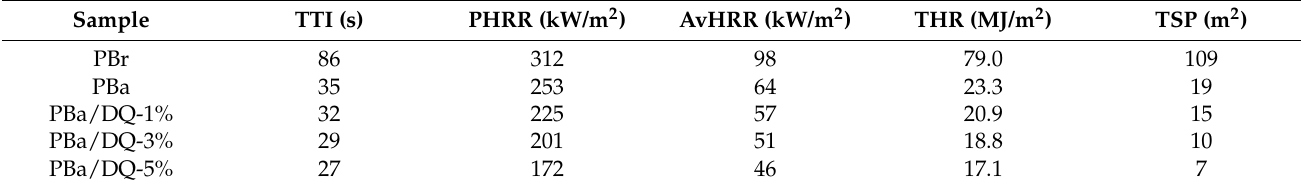
Figure 8. ( a ) HRR; ( b ) THR; ( c ) COP; and ( d ) TSR versus time curves of PBa and PBa composite aerogels obtained from the cone calorimetry test. Table 2. CONE parameters of PBr, PBa, and PBa composite aerogels.